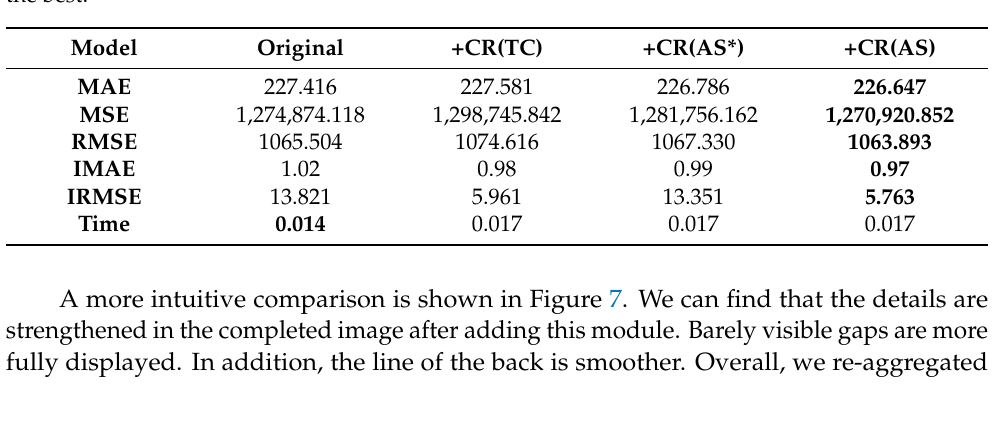
Table 3. The ablation experiments of the confidence re-aggregation module. The bold numbers are the